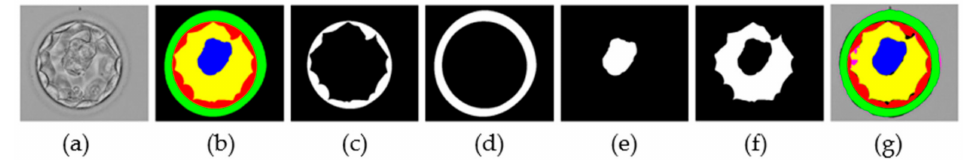
Figure 8. MASS-Net individual masks: ( a ) original image, ( b ) expert annotation by embryologist, ( c ) TE predicted mask, ( d ) ZP predicted mask, ( e ) ICM predicted mask, ( f ) BL predicted mask, and ( g ) combined predicted